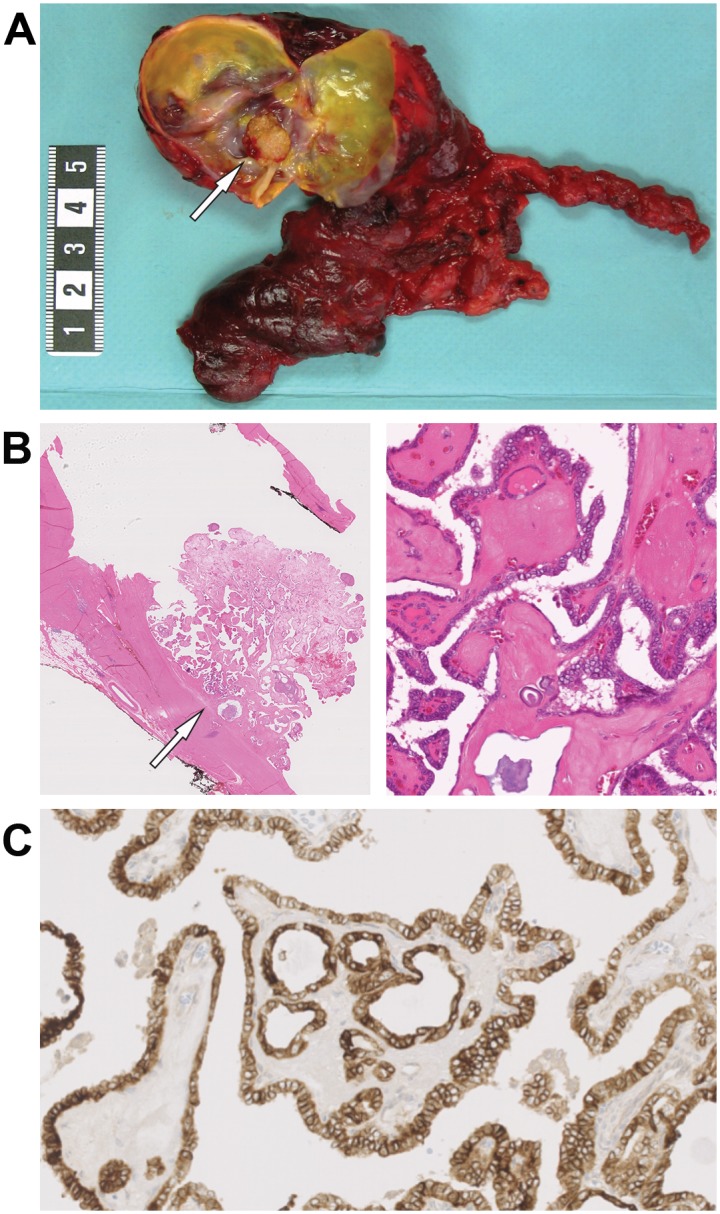
Macroscopical and histopathological features of a cPTC.(A) A mural nodule diagnosed as a cPTC (arrow) in the right lobe of a resected thyroid specimen. (B) Histopathological slide illustrating the same mural nodule (arrow) after H&E staining exhibiting histopathological features of PTC, spots of calcifications and partially fibrous capsule of thyroid cyst. The sample is shown in x7 (left) and x110 (right) magnifications. (C) Immunohistochemistry showing expression of thyroglobulin in cPTC tumor cells (magnification x40).